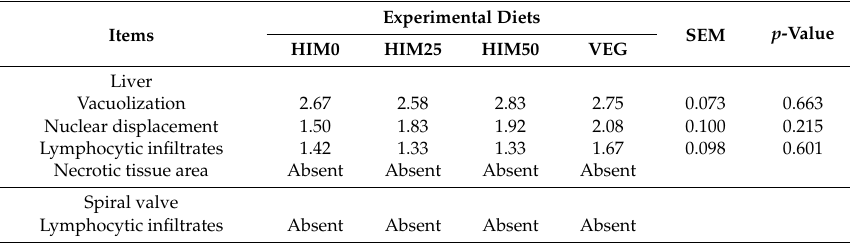
Table 3. E ff ects of dietary H. illucens larva meal inclusion on liver histopathological findings of the sturgeons ( n = 12).